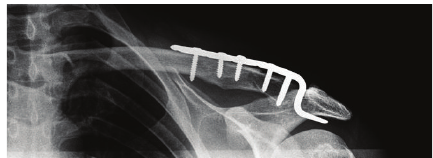
Figure 2: Initial hook plate fixation of distal clavicle.